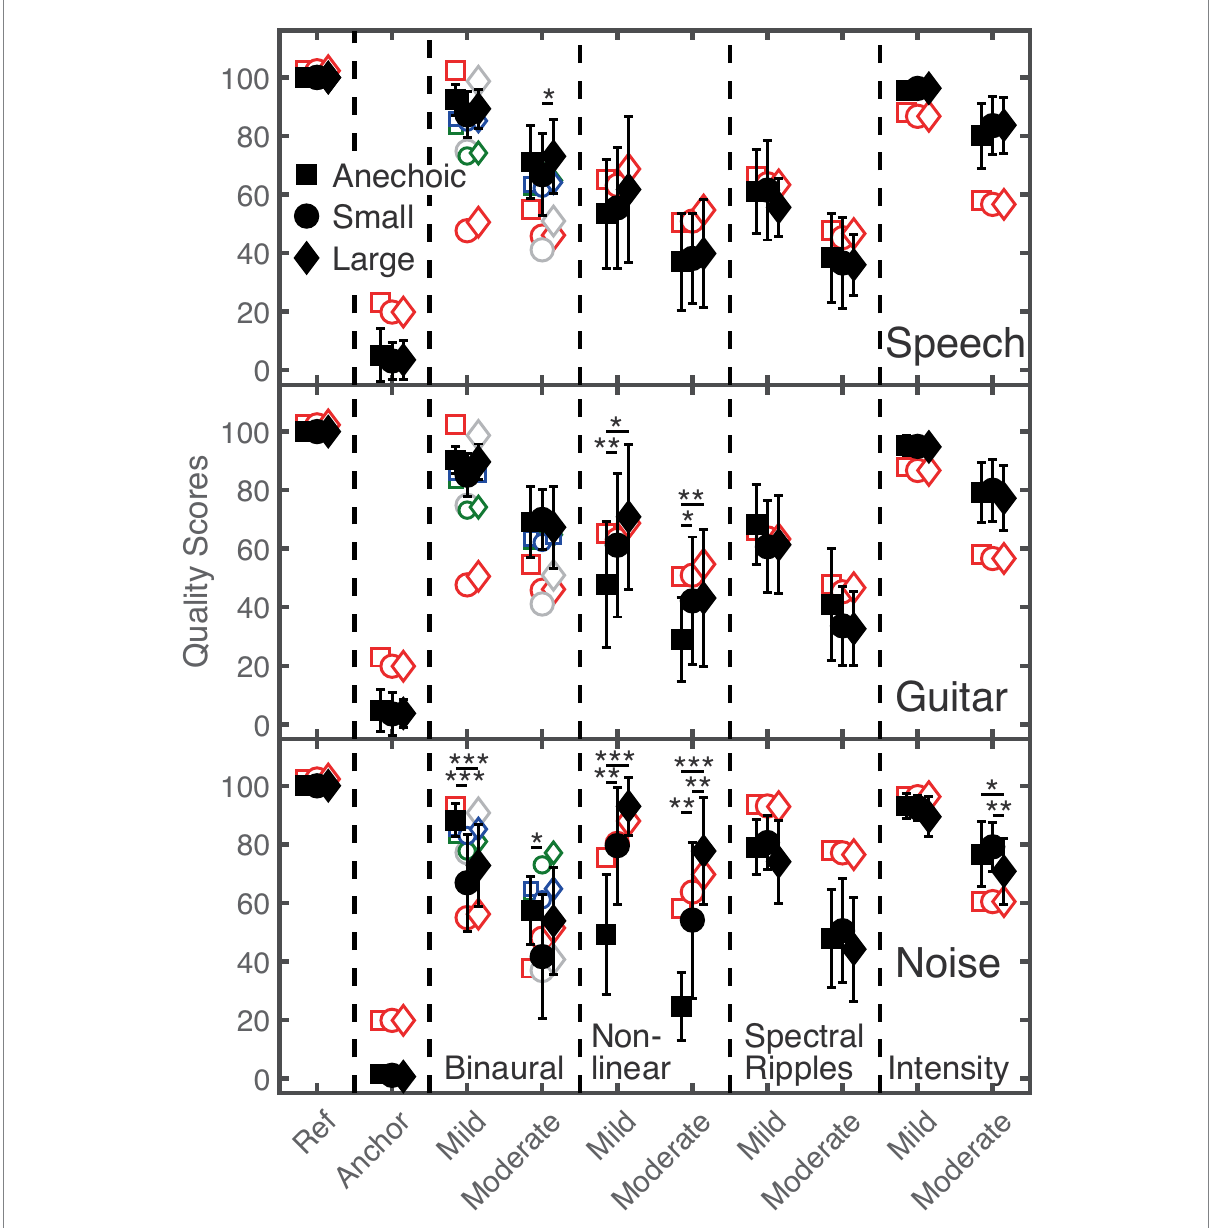
FIGURE 3 The upper, middle, and lower panels show supra-threshold audio quality ratings for speech, guitar music, and noise (black filled symbols). The ordinate represents quality scores ranging from 0 (“very strong difference”) to 100 (“no difference”). The abscissa represents the hidden reference, anchor, and type of distortion (mild and moderate amount). The Anechoic, Small, and Large room are represented by squares, circles, and diamonds, respectively. Statistically significant pairwise comparisons between rooms are indicated by the asterisks. The red and small green open symbols refer to GPSM q and BAM-Q predictions, while gray and small blue symbols refer to GPSM q and BAM-Q predictions for which only the direct sound and early reflections of the BRIRs were